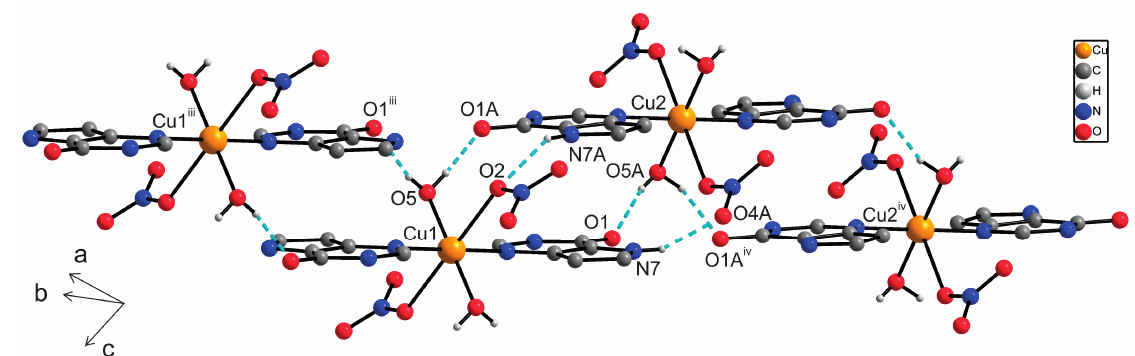
Figure 5. A part of the crystal structure of [Cu(9dhx) 2 (H 2 O) 2 (NO 3 ) 2 ] ( 2a ), showing the formation of a supramolecular polymeric chain formed through intermolecular O–H···O and N–H···O hydrogen bonds (dashed lines). Hydrogen atoms, except for the hydrogen atoms participating in hydrogen bonds, are omitted for clarity. Symmetry codes: (iii) x + 1, y, z; (iv) x − 1, y, z.